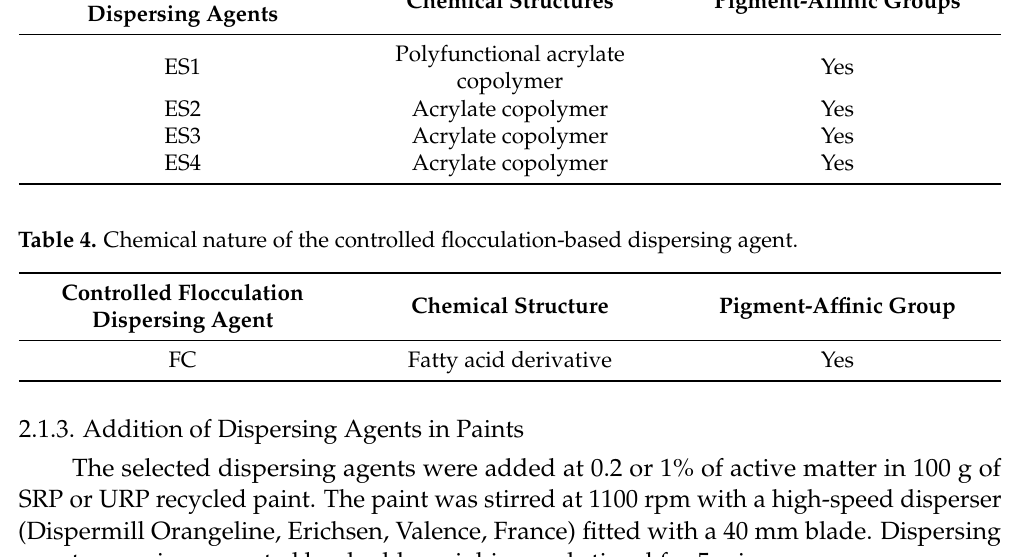
Table 3. Chemical nature of the electrosteric dispersing agents. Electrosteric Chemical Structures